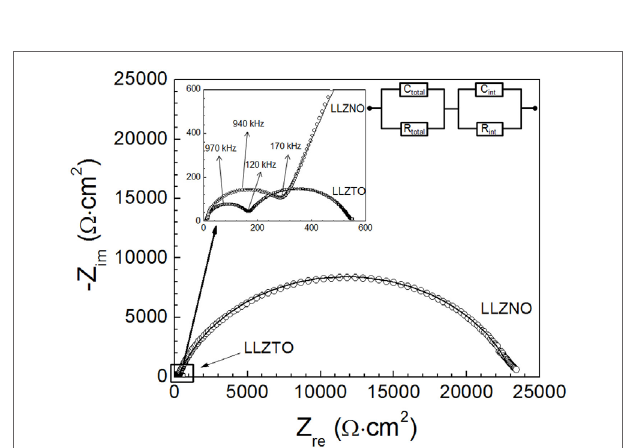
FigUre 3 | The impedance spectrum with fitted line for as-fabricated li–llZnO (or llZTO)-li symmetric cells at 23.5 ± 1°c . The solid line corresponds to the fitted the result of the equivalent circuit ( ○ :